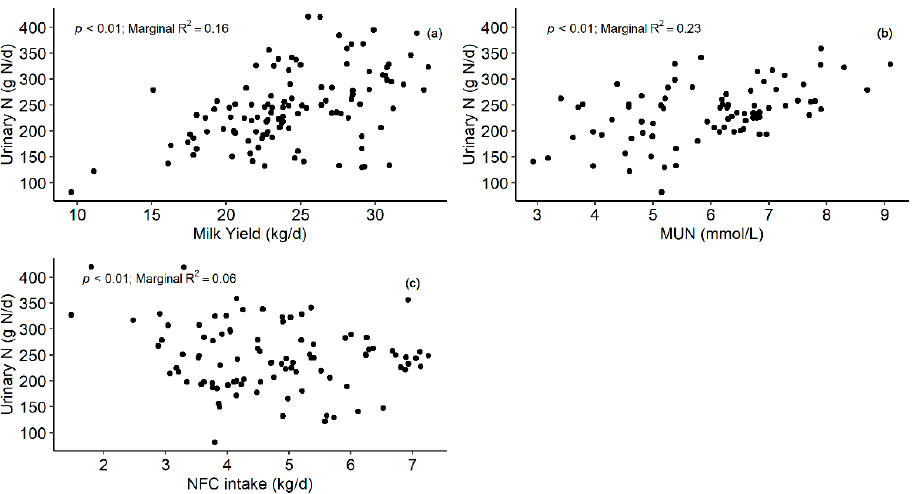
Figure 4. Relationship between urinary N excretion and ( a ) Milk yield; ( b ) Milk urea Nitrogen (MUN); and ( c ) non ‐ fibrous carbohydrates (NFC) intake in dairy cattle.